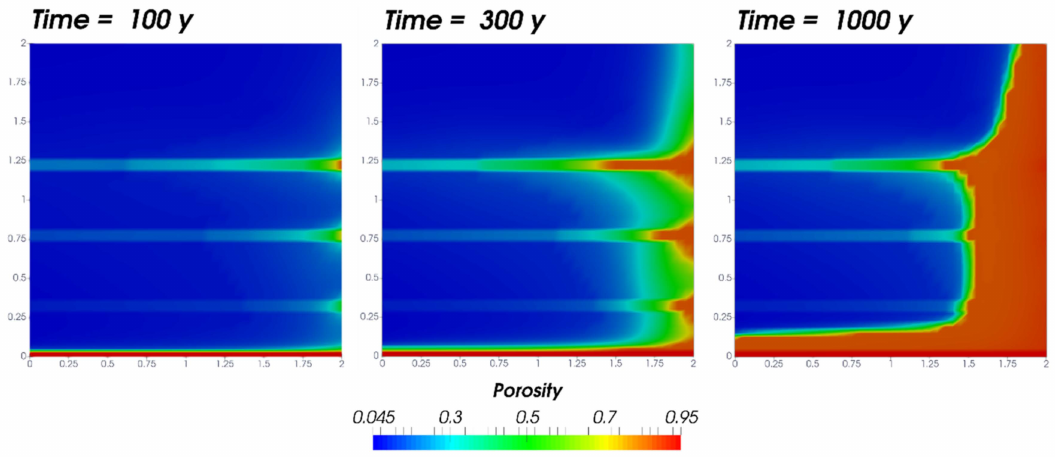
Figure 10. Spatial distribution of the computed porosity after 100, 300, and 1000 years of the simulation in scenario 3.